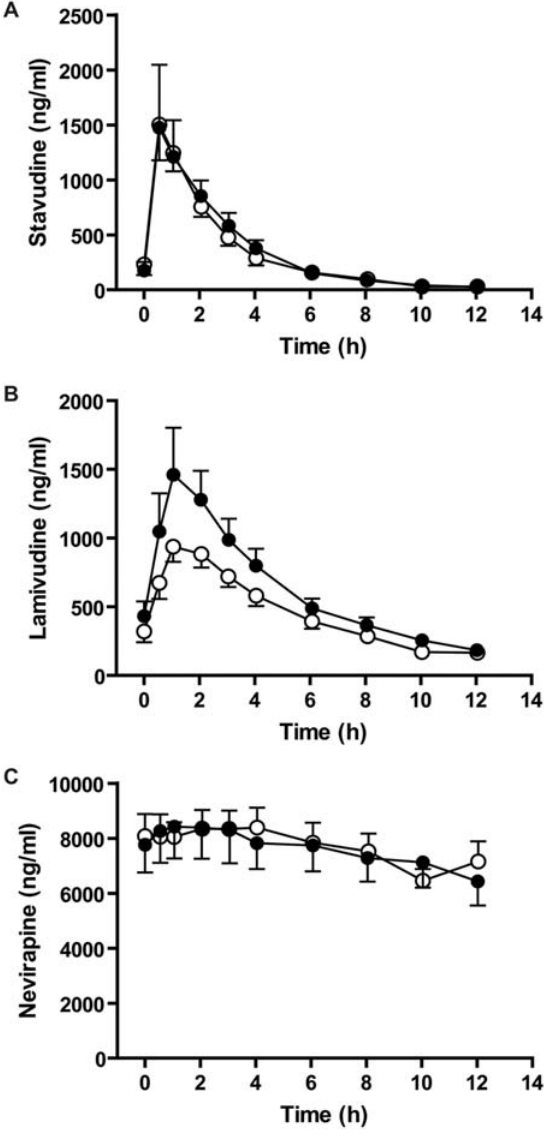
Figure 1. Plasma concentration-time profiles for brand and generic stavudine, lamivudine and nevirapine. Mean plasma concentration-time profiles of (A) stavudine, (B) lamivudine and (C) nevirapine in 18 subjects after oral administration of brand (closed symbol) or generic (open symbol) formulation. Each value represents the arithmetic mean 6 SE for 18 subjects in each arm.